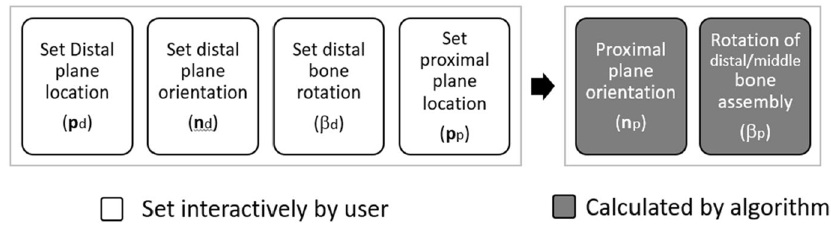
Figure 3. Osteotomy parameters. The distal plane parameters ( p d , n d , β d ) and the location of the proximal plane ( p p ) are interactively set by the user. The orientation of the proximal plane ( n p ) and the rotation angle of the distal-middle bone assembly ( β p ) are calculated by the algorithm.